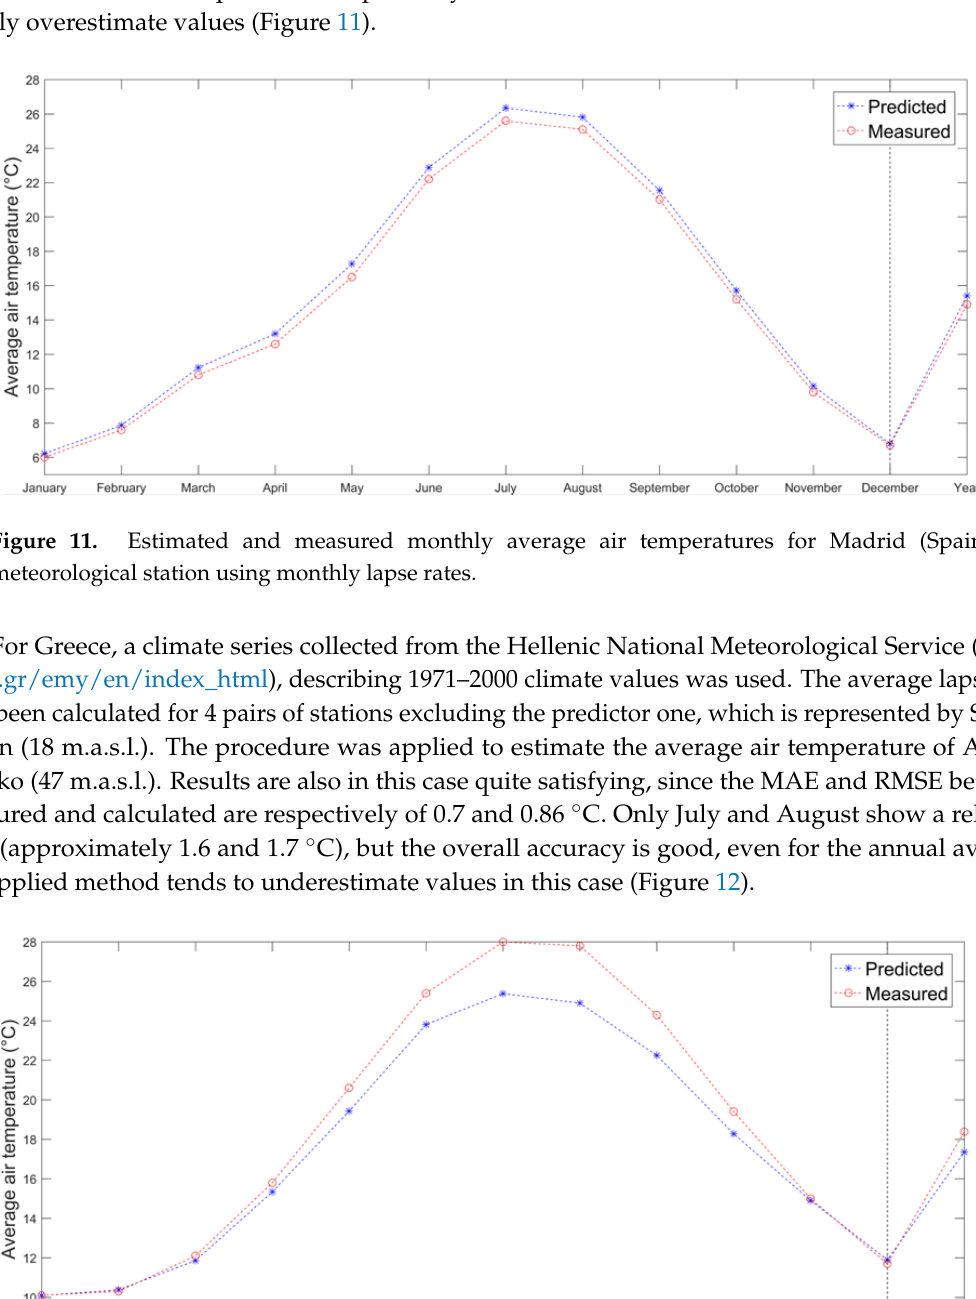
Figure 12. Estimated and measured monthly average air temperatures for Athens (Greece) meteorological station using monthly lapse rates.